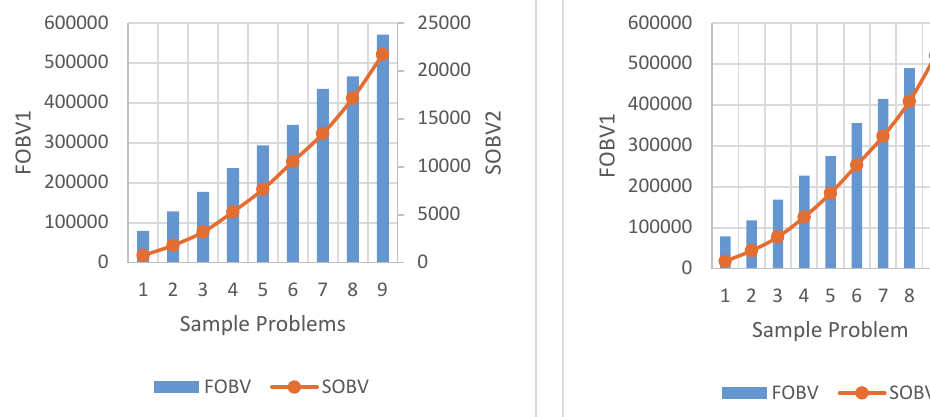
Fig. 14 . Changes in the first and second objective function in different sample problems by MOPSO algorithm